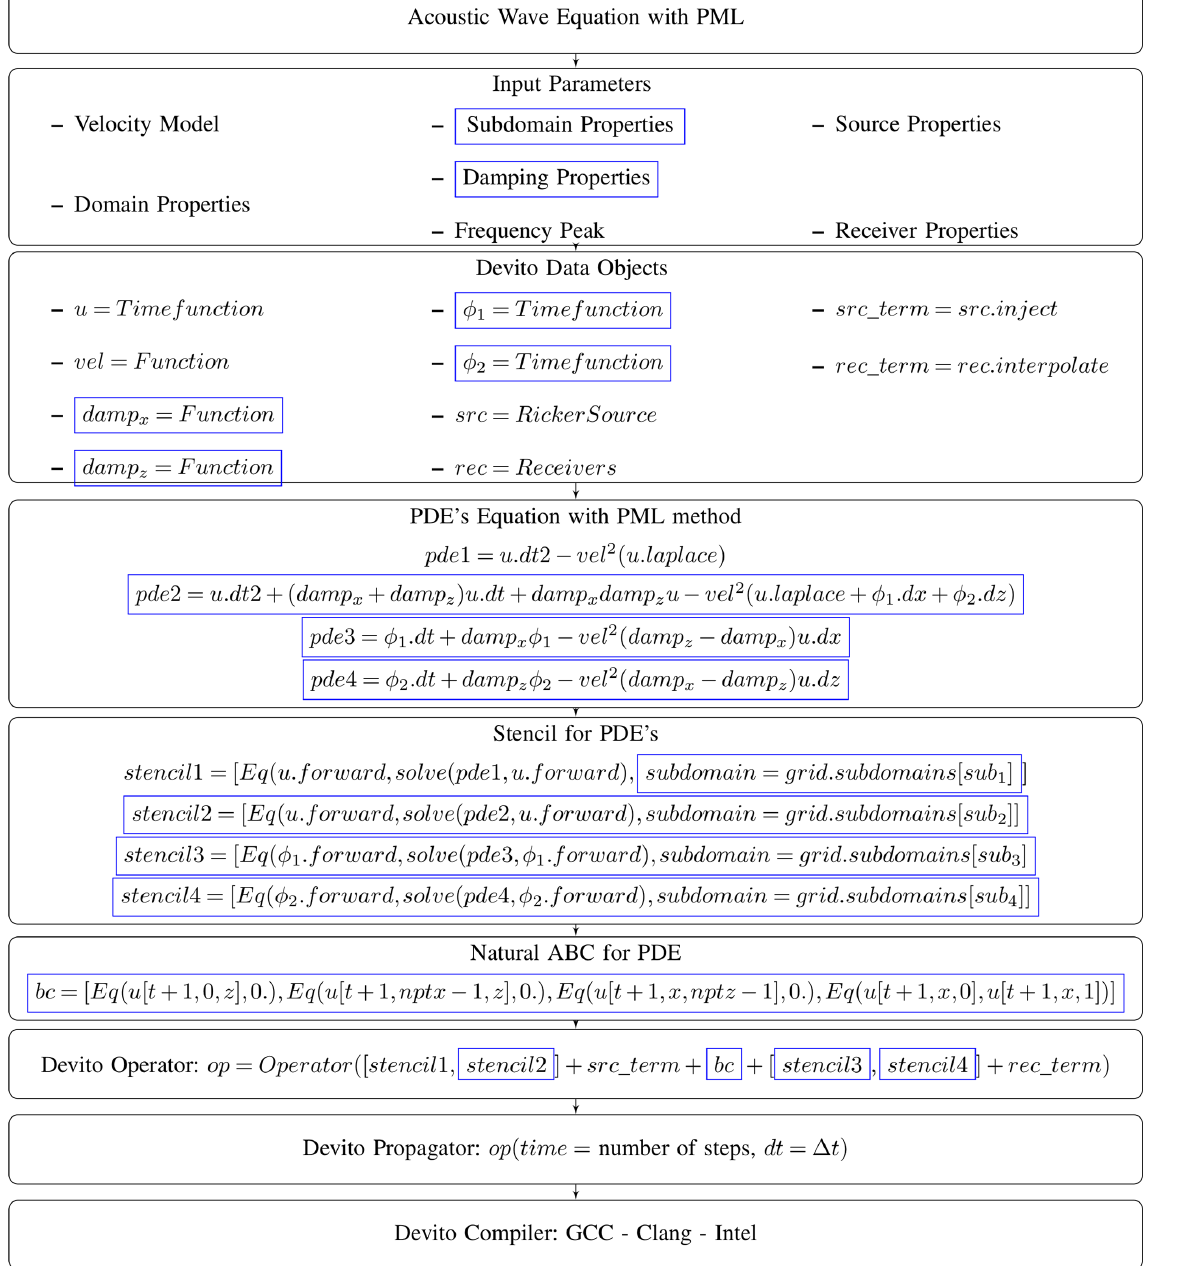
range of p was taken to be 1 < p < 20. Previous works